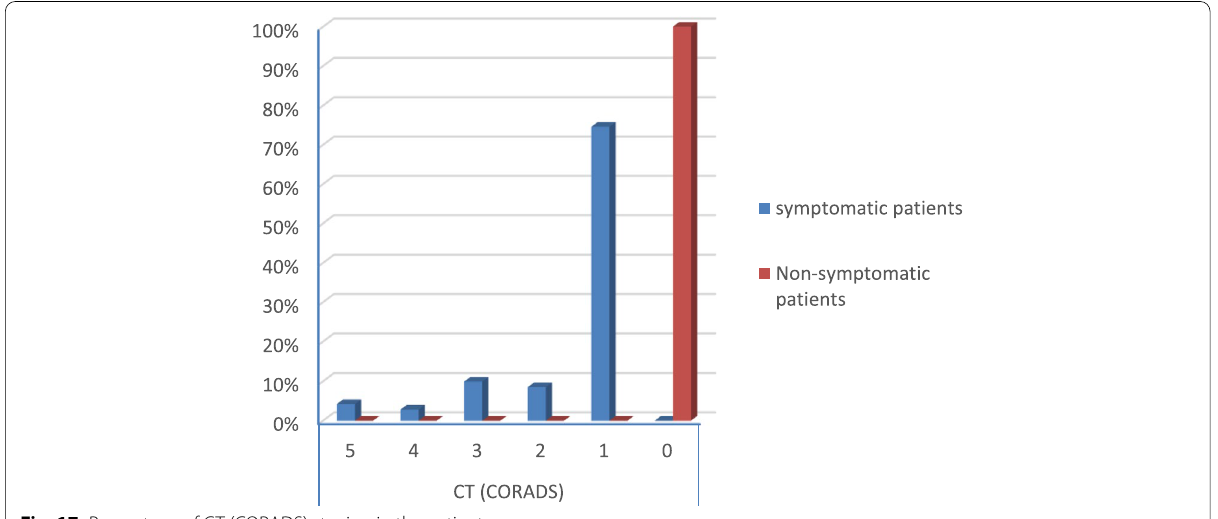
Fig. 17 Percentage of CT (CORADS) staging in the